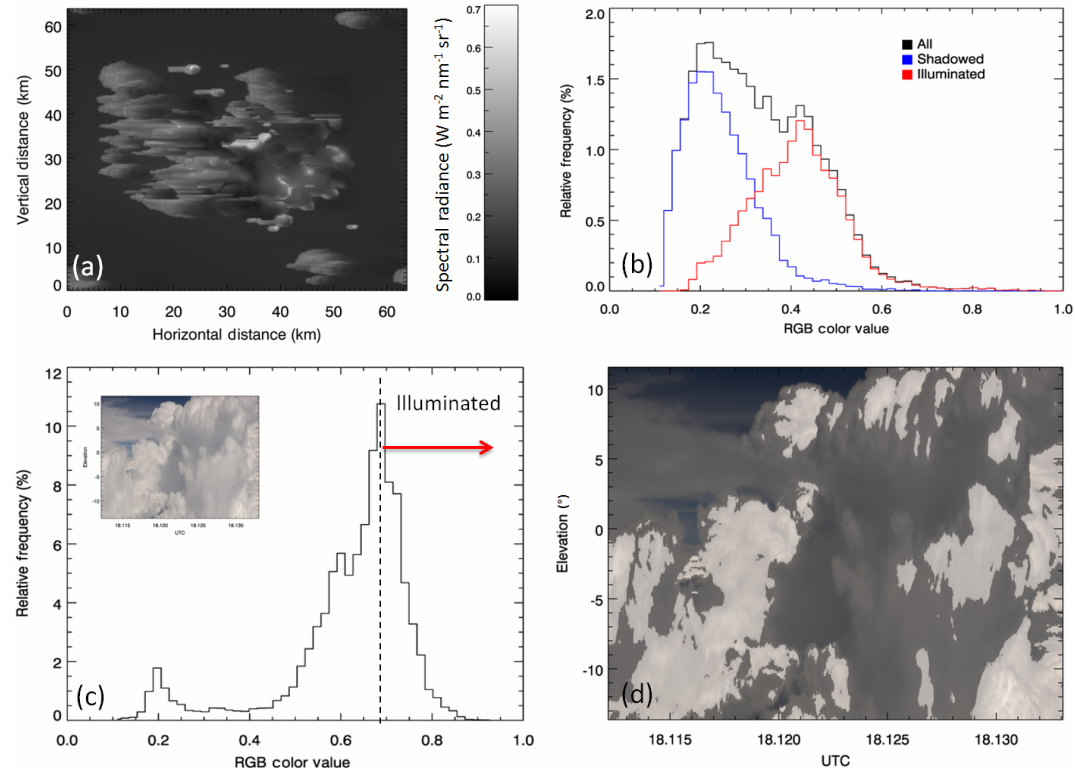
Figure 3. (a) Field of RGB color values from simulated spectral radiances for cloud-side viewing geometry with a sensor elevation angle of 10 ◦ and a relative azimuth angle of 60 ◦ . (b) Histogram of RGB color values of the field shown in (a) . (c) Histogram of RGB color values for a measured cloud scene shown in the inset. (d) Identified illuminated cloud sides of the observed cloud scene are highlighted in brighter